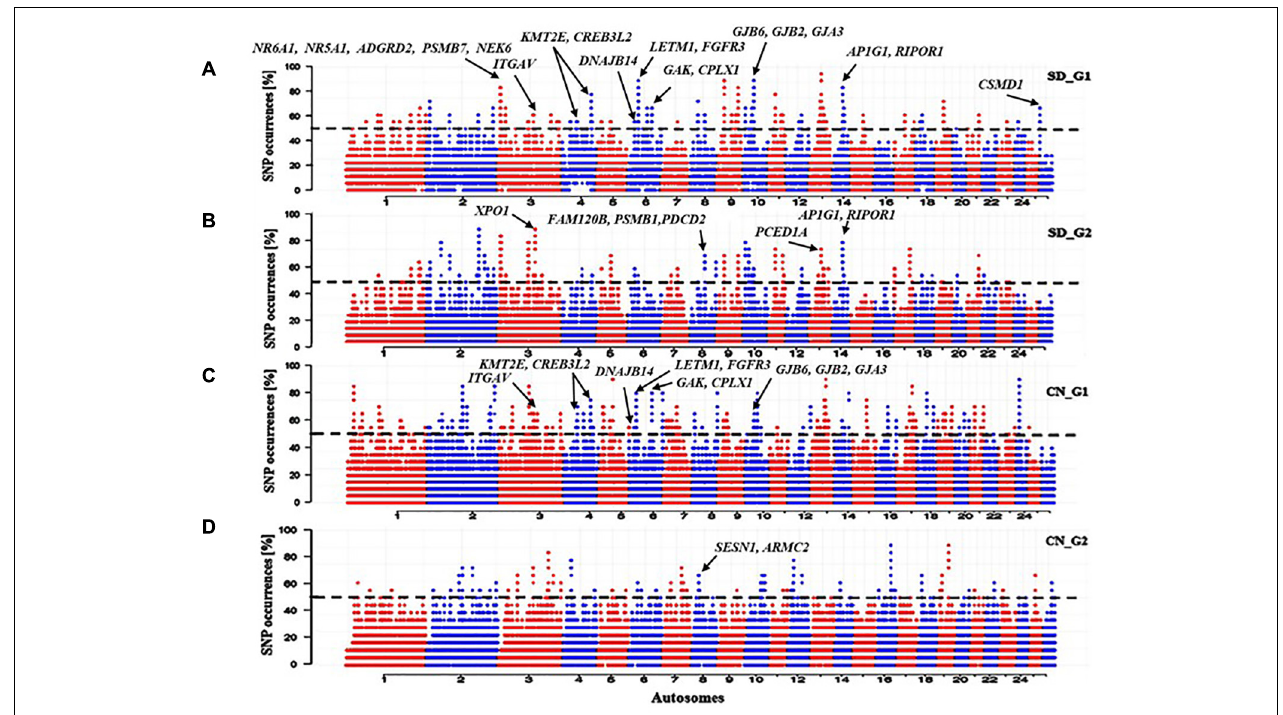
FIGURE 4 | Manhattan plots of genome-wide distribution frequency of SNPs in stretches of ROH regions for (A) SD_G1 genetic group of thin-tailed Desert Sheep from Sudan; (B) SD_G2 genetic group of thin-tailed Desert Sheep from Sudan; (C) CN_G1 genetic group of Chinese sheep; (D) CN_G2 genetic group of Chinese sheep. The dashed lines indicate the 50% cut-off threshold for each groups of